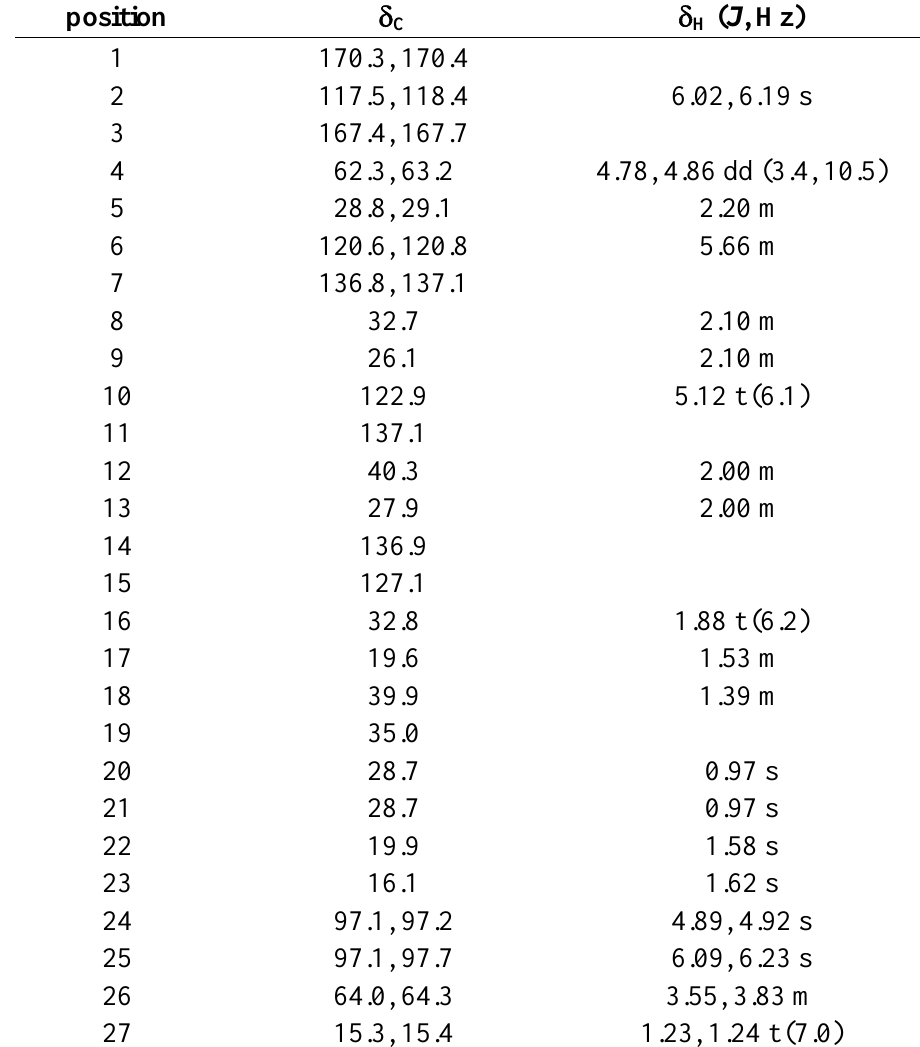
) for 24- O -ethylmanoalide ( 3 ) a 3